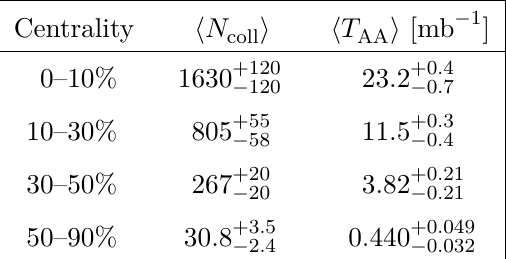
Table 1 . The values of h N collisions for the centrality ranges used in this analysis